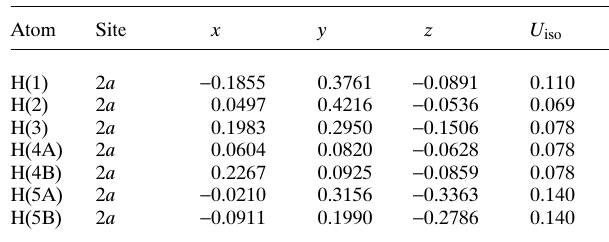
Table 2. Atomic coordinates and displacement parameters (in Å 2 )